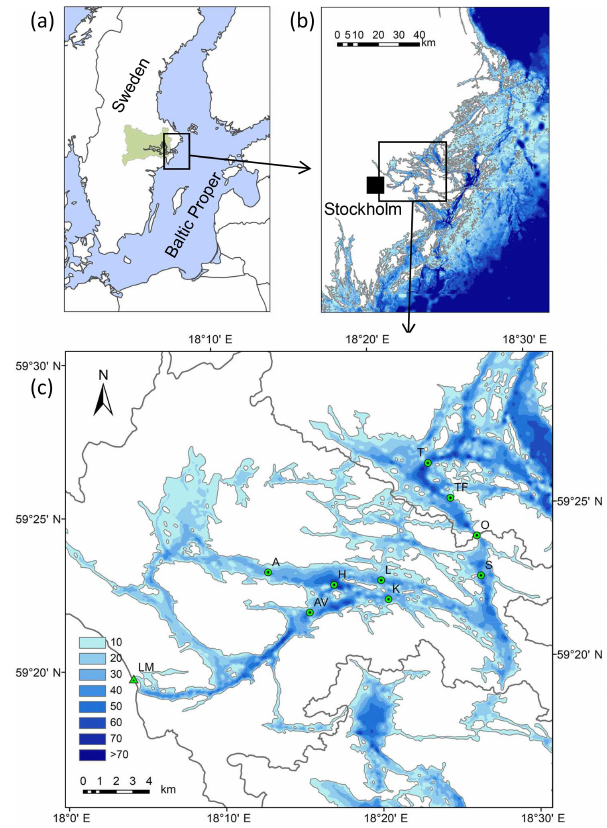
Figure 1. Maps showing the location of the Stockholm inner archipelago (IA) in the north-western Baltic Proper. Lake Mälaren with drainage area is shown in the top left map and its outlet Norrström in Stockholm (LM) in the lower map. The small local drainage area of the IA is shown in the lower map. The central sta- tions (A, AV, H, L, and K) were used to represent the IA. The main water exchange between the IA and middle archipelago is through Oxdjupet (O). Data from Trälhavet (T) were used to represent in- flowing water. Surface water data from Solöfjärden (S), Oxdjupet (O), and Trälhavet Fiskare (TF, weekly station for surface water) were used to represent outflowing water of the boundary model. Depths (m) in maps are spline interpolated from nautical chart data (scale 1:25000, published